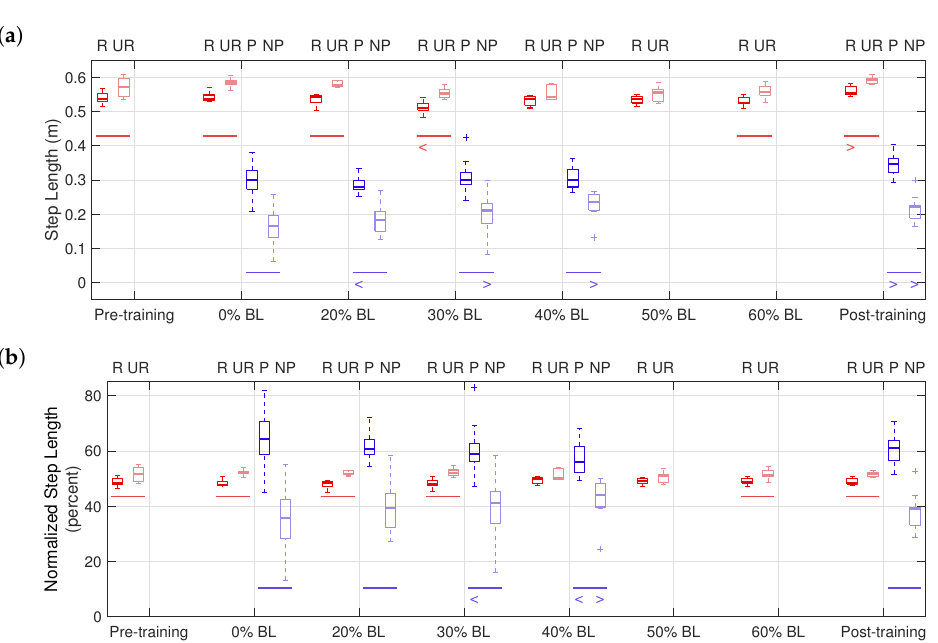
Figure 13. Raw and normalized step lengths in the pilot study. ( a ) Step lengths. ( b ) Step lengths normalized by sum of median